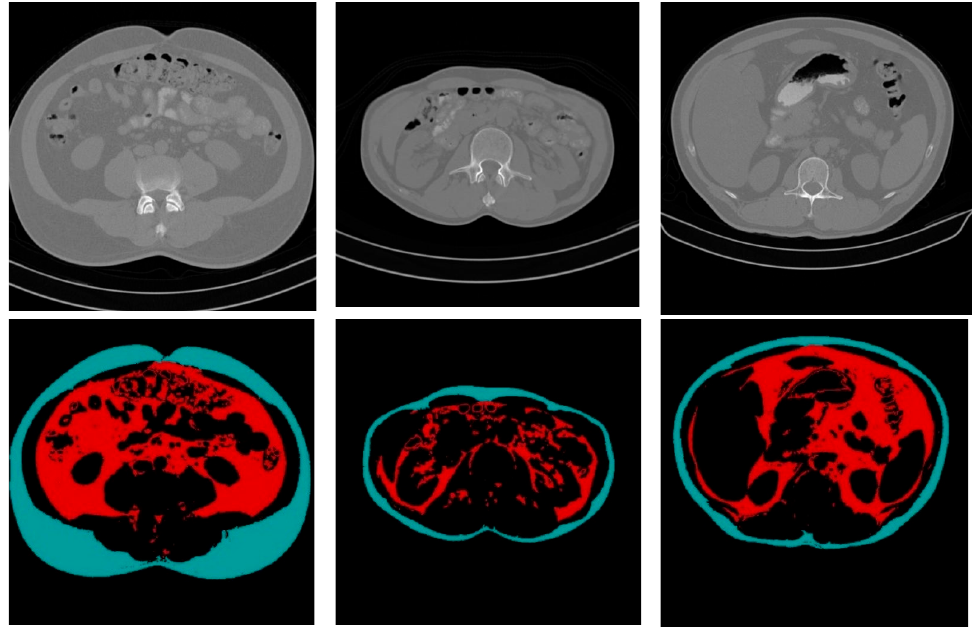
Figure 10. Samples of the original CT images and the results of fat segmentation and classification.